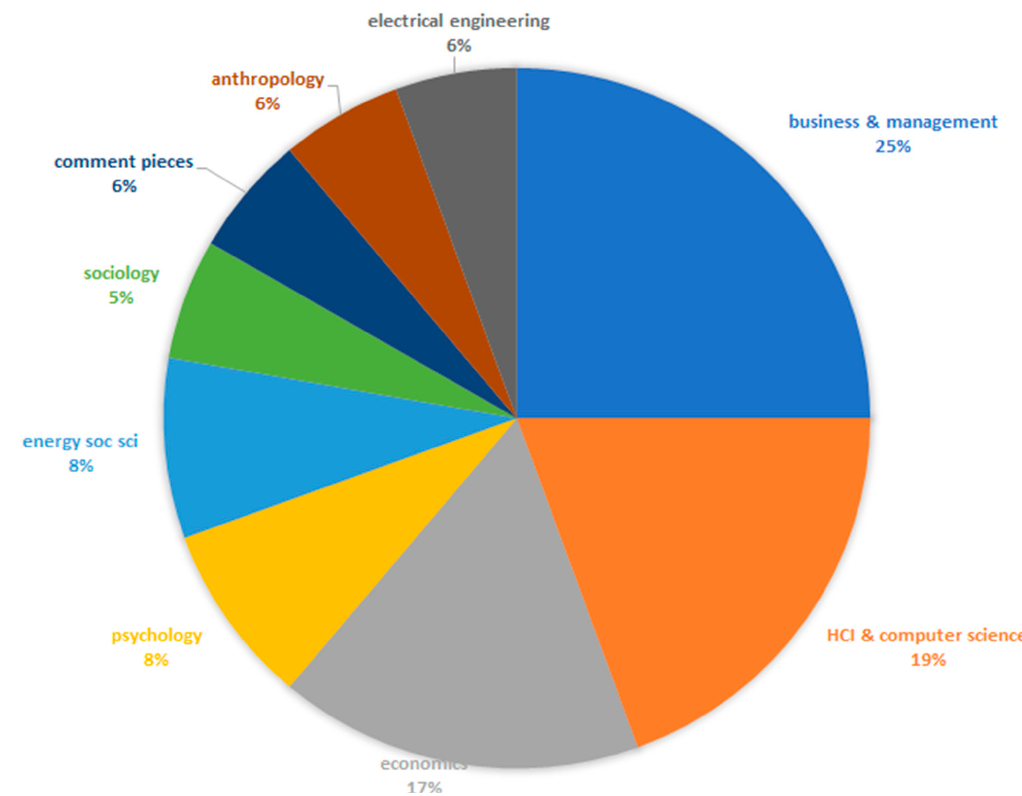
Figure 4. The main discipline of reviewed studies.